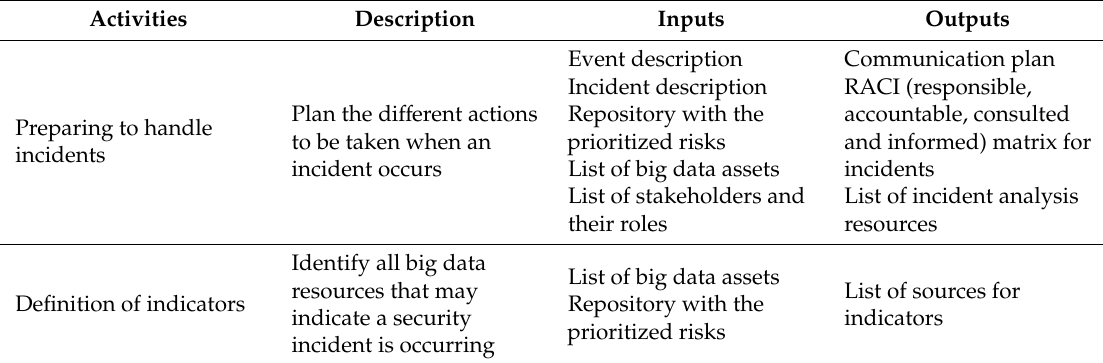
Table 4. Activities of Phase 2: